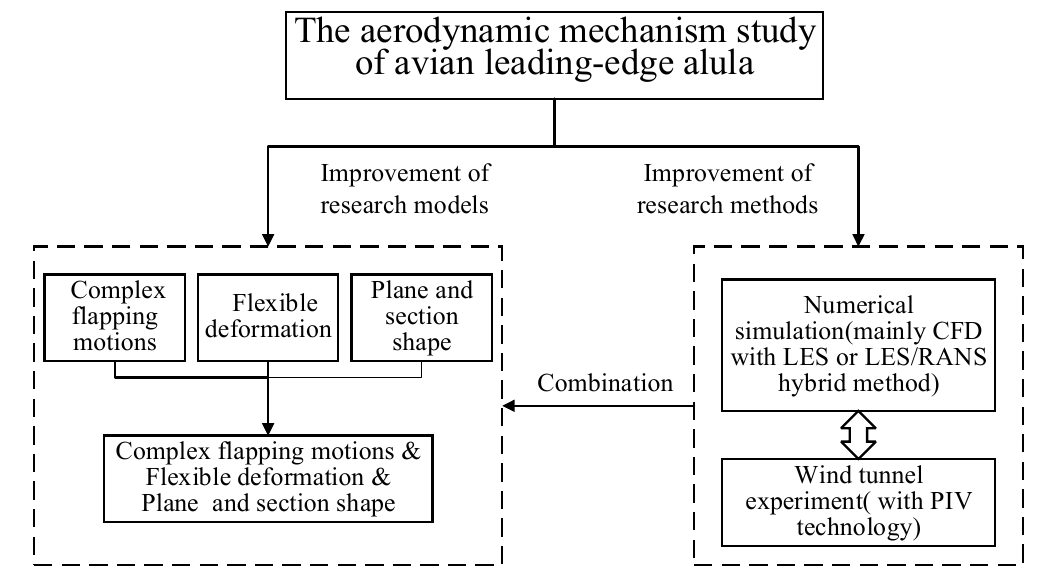
Figure 13. Predictions for studying the aerodynamic mechanisms of the avian leading-edge alula.